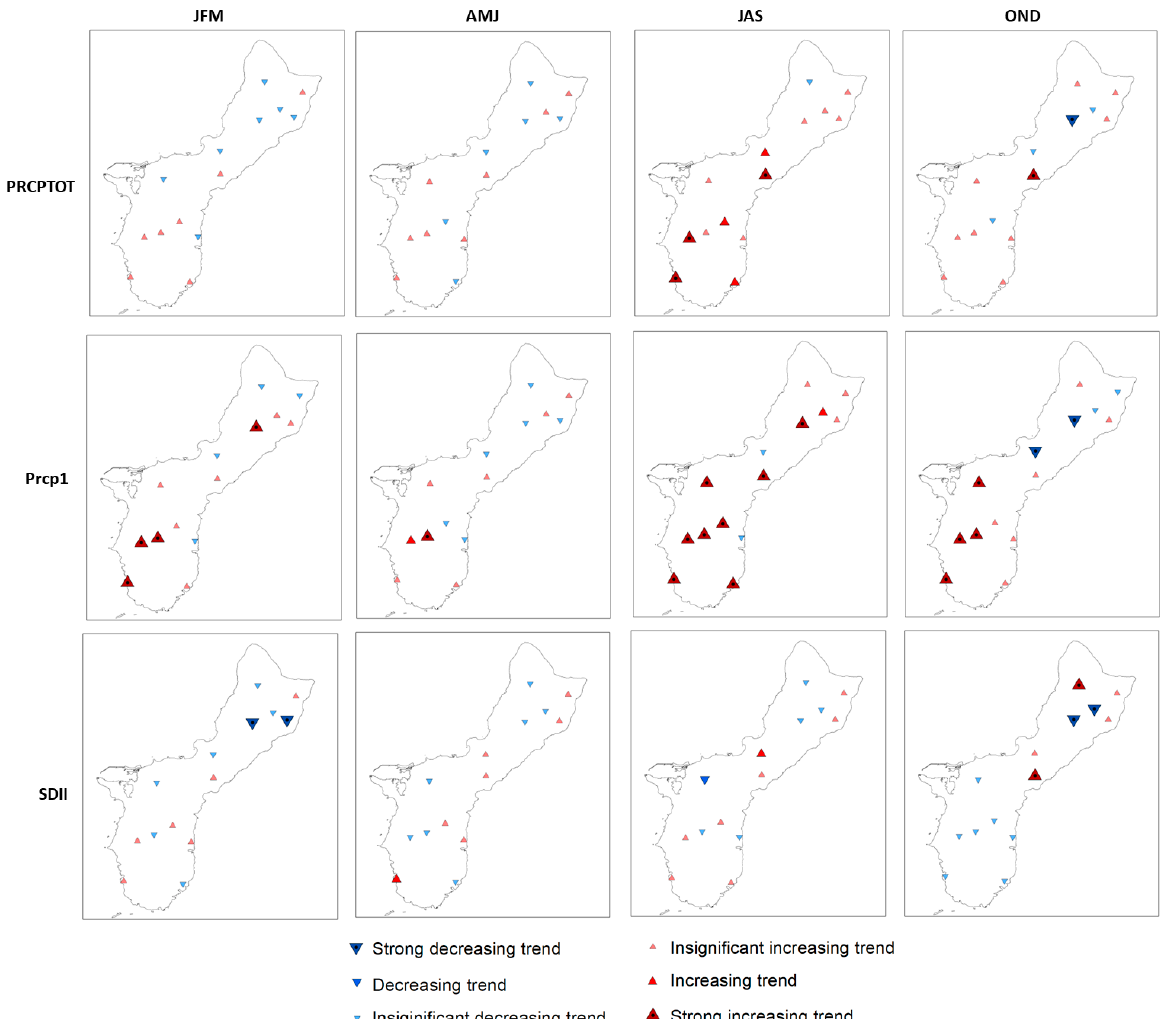
Figure 5. Spatial distributions of seasonal trends of the basic rainfall indices: total precipitation in wet days (PRCPTOT, mm)), the percentage of wet days (Prcp1, %), and the simple precipitation intensity index (SDII, mm). Columns represent each season, and rows represent each index.